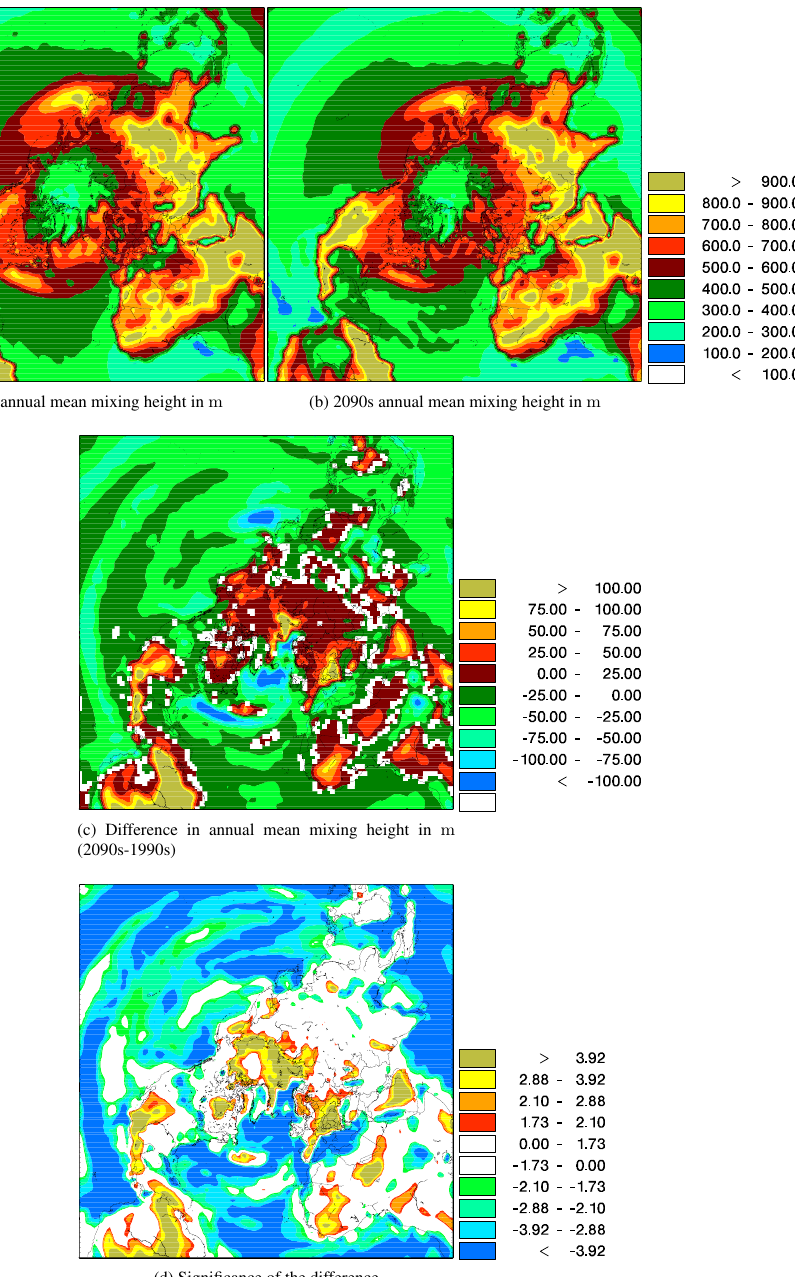
Fig. 2: Annual mean mixing height in m , displayed as in Fig. 1 Fig. 2. Annual mean mixing height in m, displayed as in Fig.